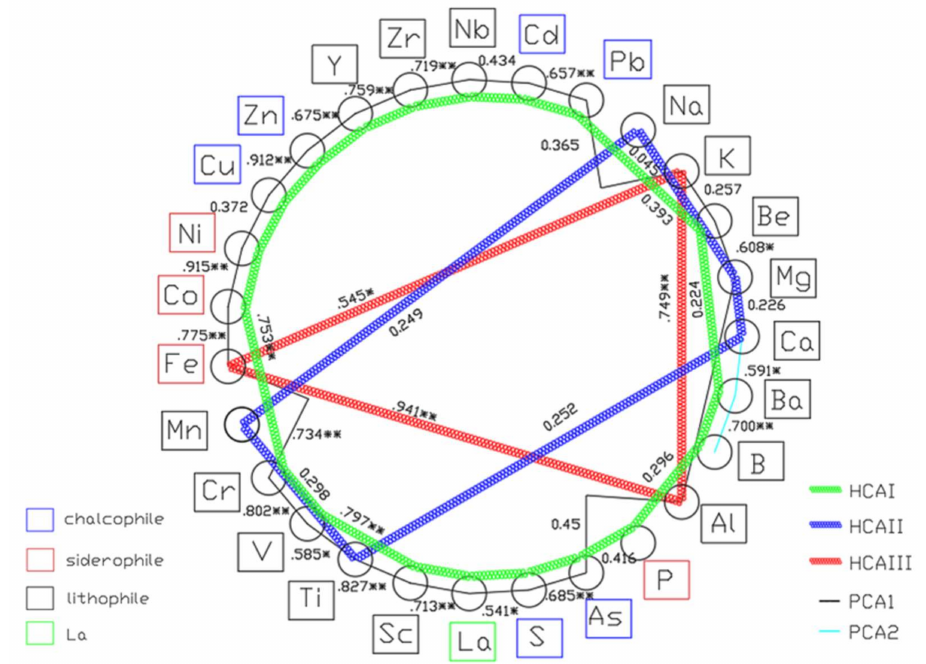
Figure 6. Element map. ** Significant correlation at the 0.01 level (two tailed); * significant correlation at the 0.05 level (two